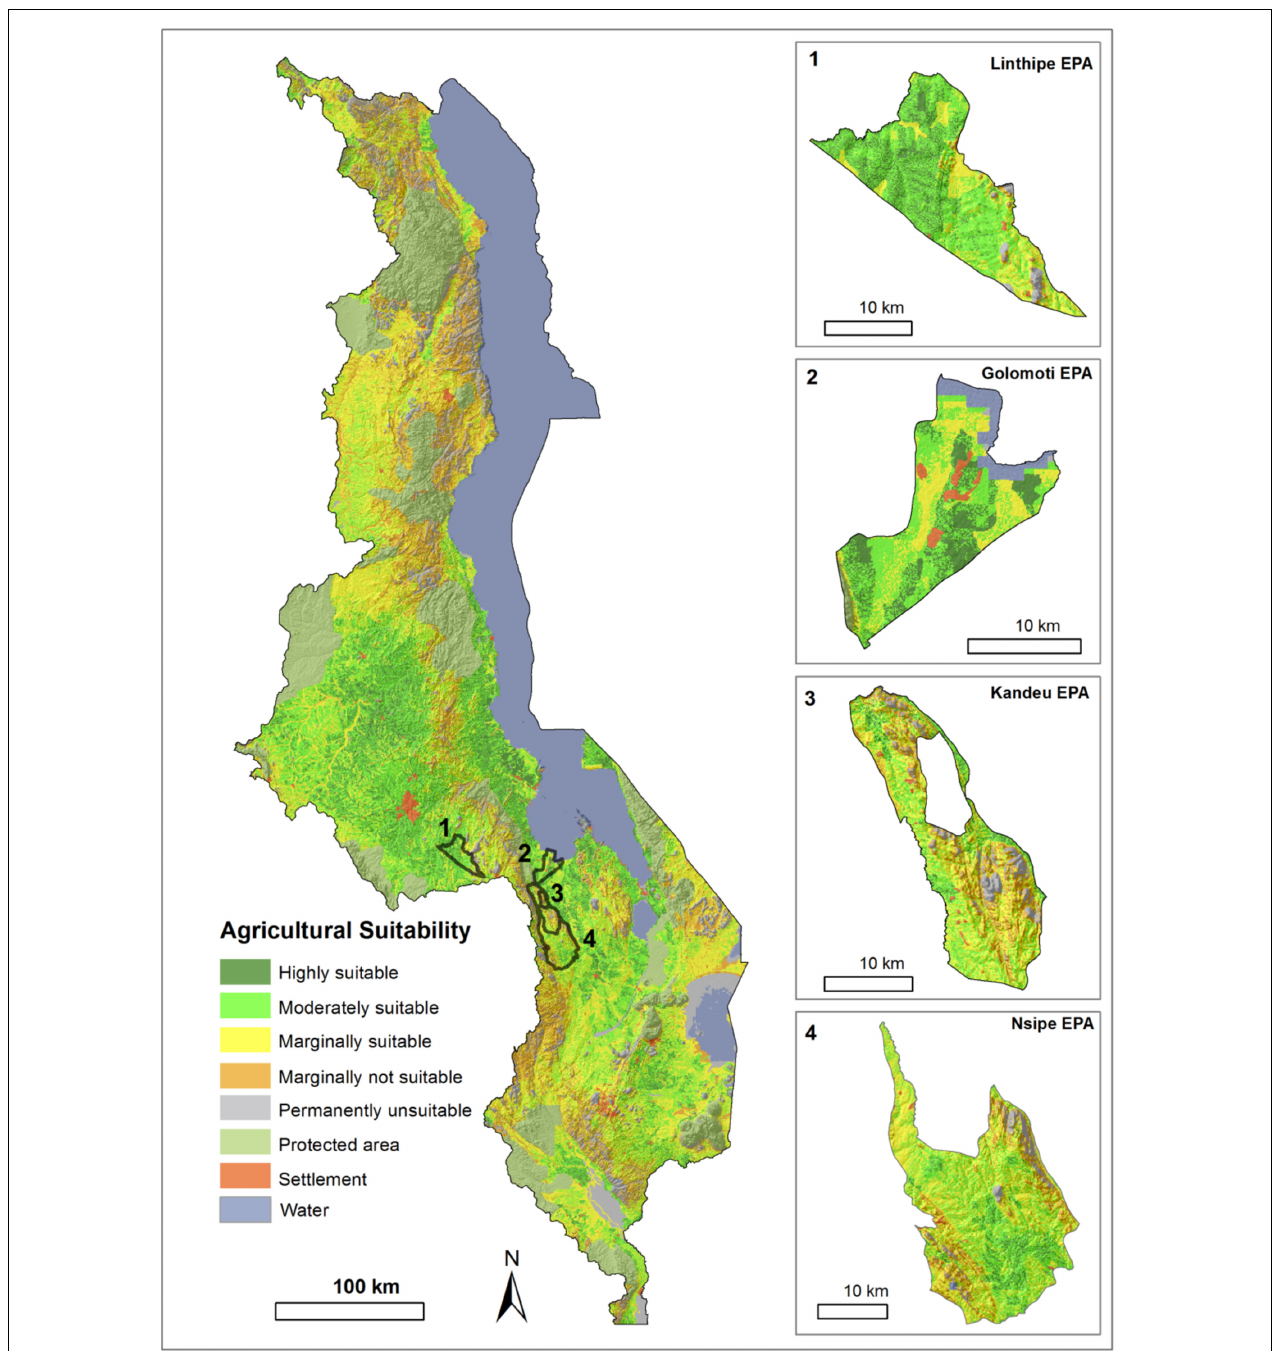
FIGURE 2 | Malawi agricultural land suitability 2 Map that highlights the four EPA